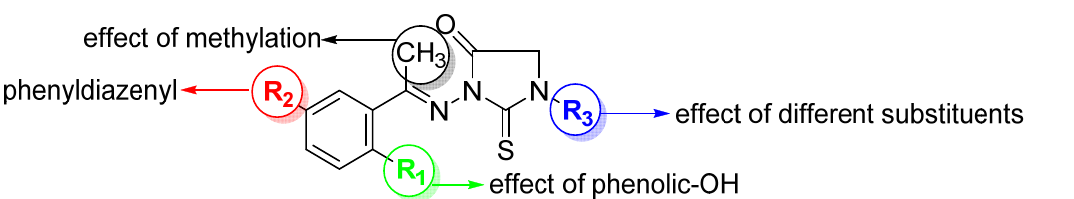
Figure 2. Design of a set of 1,3-disubstituted-2-thioxo-imidazoidin-4-one analogues.